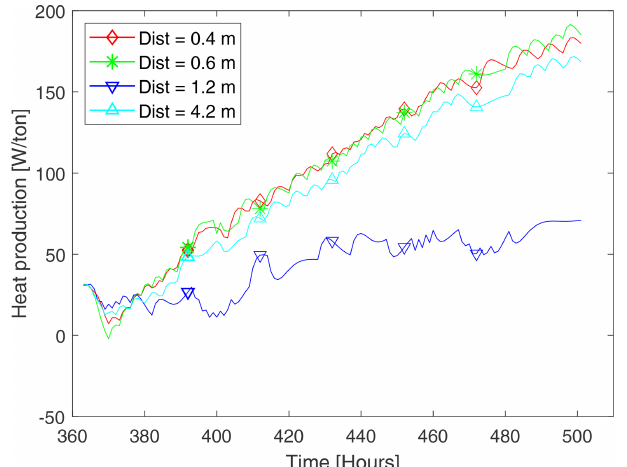
Figure 7. Change of estimated k M values over time estimated by the Cool-Ident model. Banana boxes at different pallet positions in- side the container. The legend gives the distances from the boxes to the cooling unit.